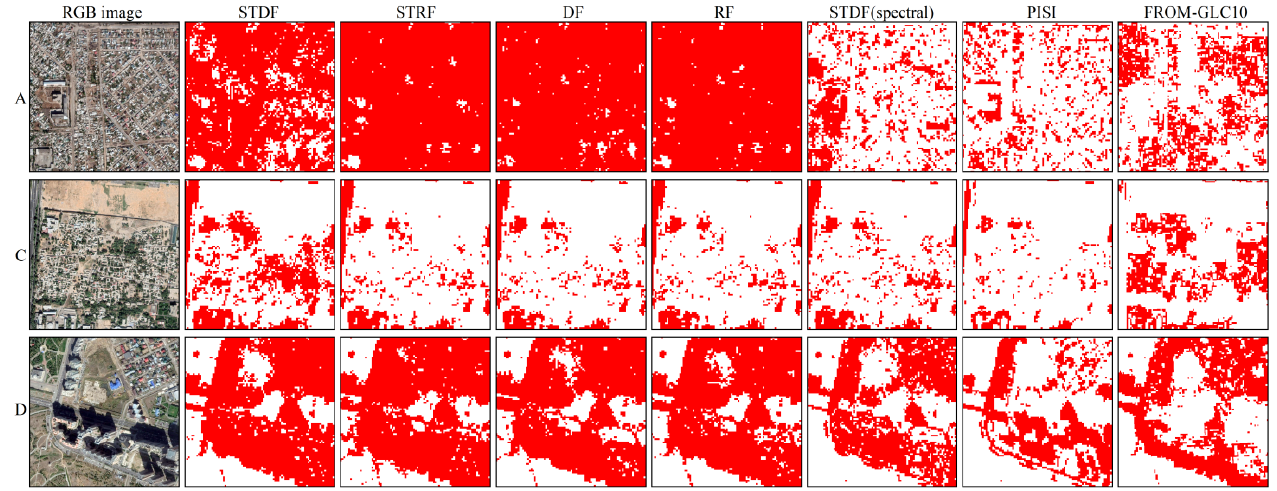
Figure 6. Comparison of ISA extraction results with a local zoom. The images in the first column were taken from Google Earth. Red indicates ISA. Areas A, C, and D correspond to those in Figure 5.